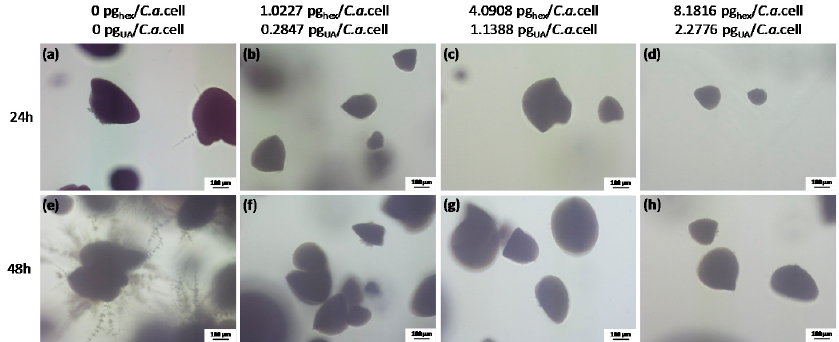
Figure 5. The representative photomicrographs of the Candida albicans ( C.a. ) cells imaged after incubation for 24 h ( a – d ) and 48 h ( e – h ) in the embedded conditions in agar: ( a , e ) without hexosomes, which served as a control; ( b , f ) with 1.0227 pg hex / C.a. cell (or 0.2847 pg UA / C.a. cell); ( c , g ) with 4.0908 pg hex / C.a. cell (or 1.1388 pg UA / C.a .cell); and ( d , h ) with 8.1816 pg hex / C.a. cell (or 2.2776 pg UA / C.a .cell); all scale bars represent 100 µm.